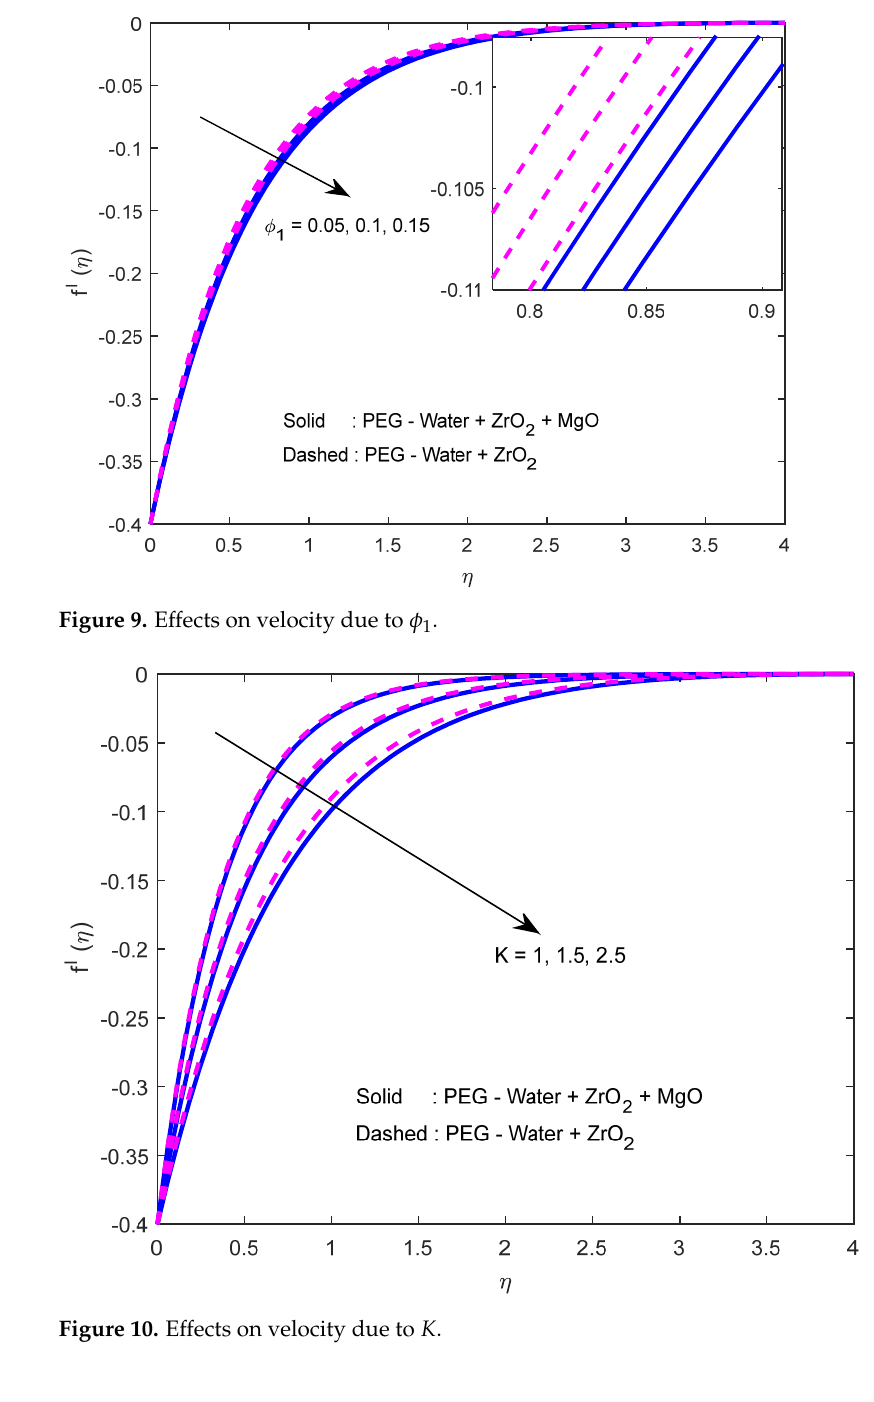
Figure 11. Effects on velocity due to 1  .